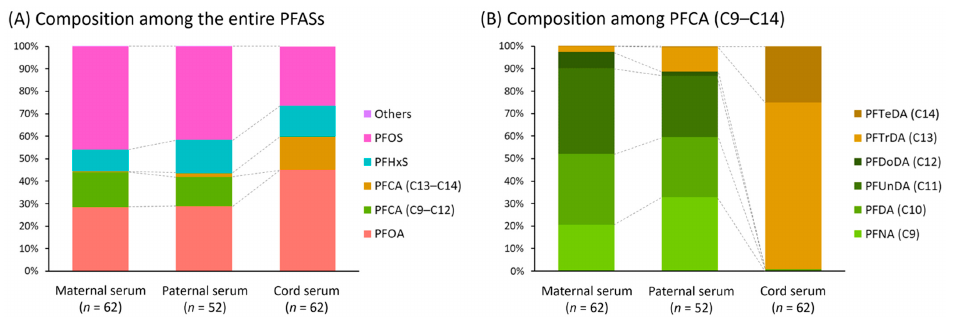
Figure 1. Composition of perfluoroalkyl substances (PFASs) in maternal, paternal, and cord serum. ( A ) Composition among the entire PFASs. ( B ) Composition among PFCA with carbon-chain lengths of 9 to 14 (C9–C12). “Others” in Figure 1A includes PFPeA, PFHxA, PFHpA, and PFBS.